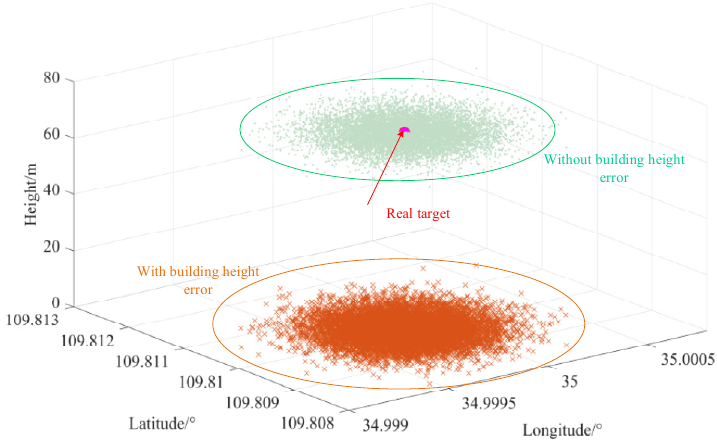
Figure 14. Schematic diagram of the distribution of positioning results.